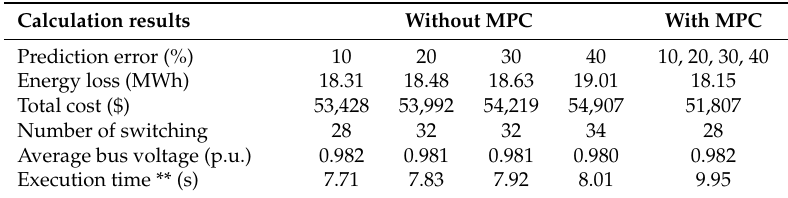
Table 6. Evaluating the effectiveness of the proposed Mixed Integer Linear Programming (MILP)-stochastic MPC model in